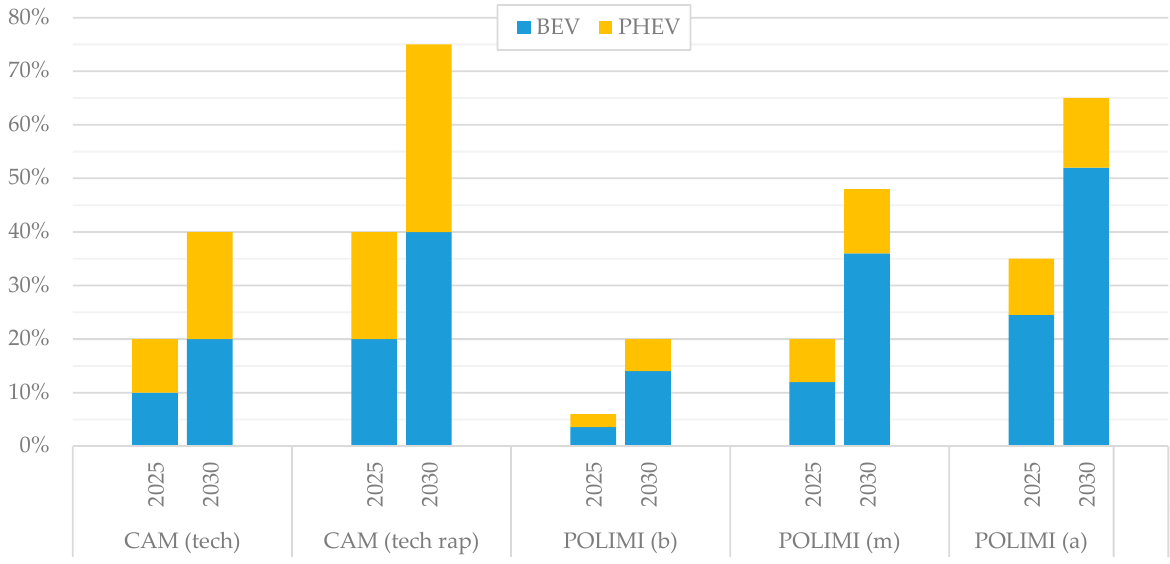
Figure 4. Estimated average BEV and PHEV penetration index on car sales, for 2025 and 2030, at Italian level, based on different forecasting